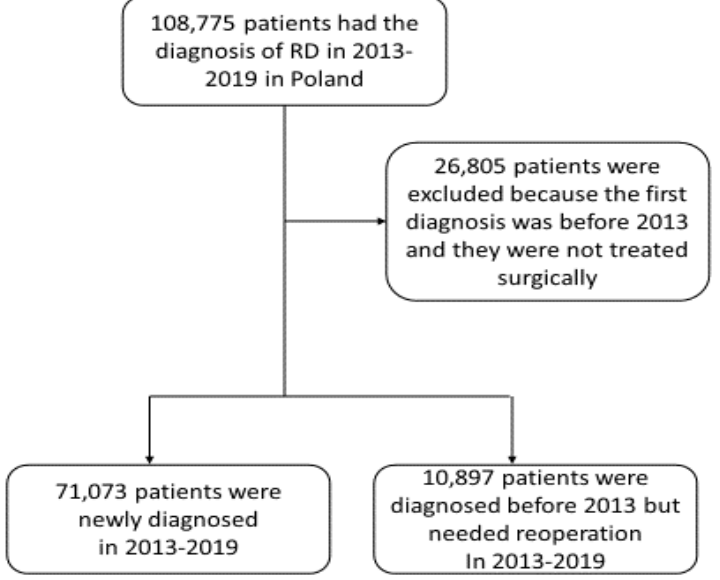
Figure 1. The study flowchart.